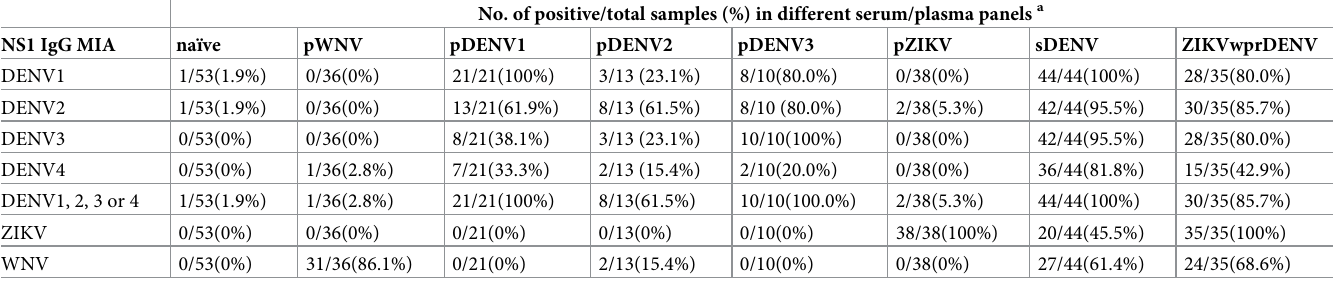
Table 1. Results of NS1 IgG MIA in different serum/plasma panels. No. of positive/total samples (%) in different serum/plasma panels a